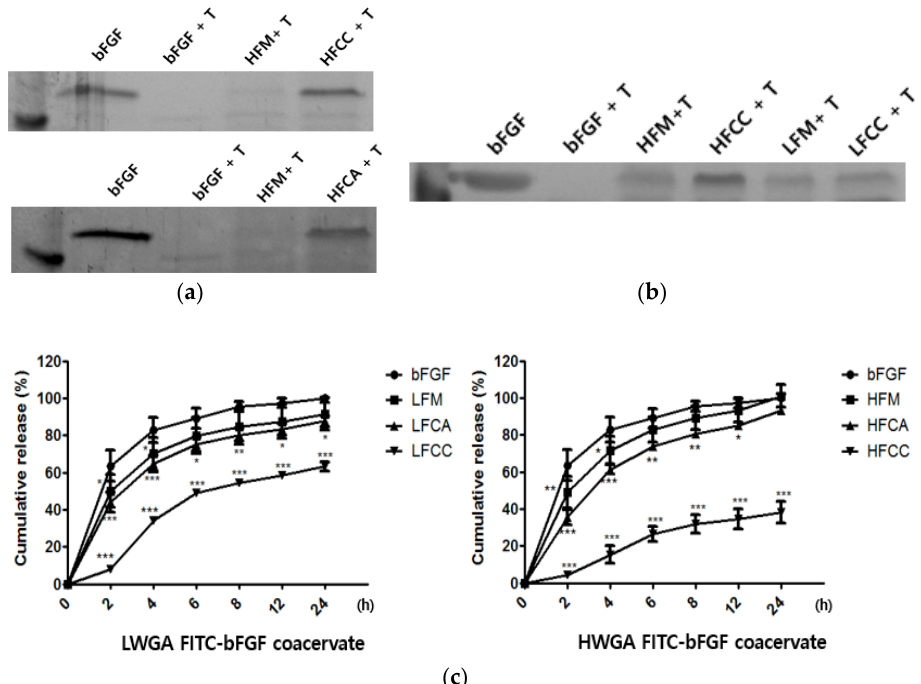
Figure 3. Comparison of LWGA ‐ SA and HWGA ‐ SA coacervates with corresponding free solutions and physical mixtures. ( a , b ) Trypsin digestion assay of bFGF in various samples after incubation with trypsin for 2 h. ( c ) Quantitative release profiles of FITC ‐ bFGF from various systems. *** p < 0.001 , ** p < 0.01 , * p <